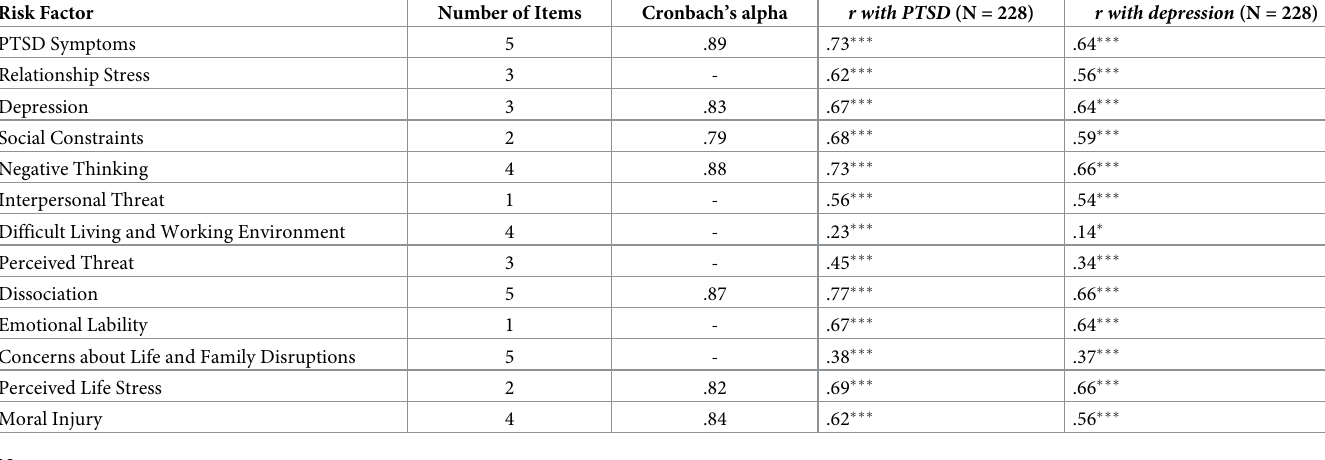
Table 4. Correlations in cross-validation study between scores for selected risk factor item sets at enrollment and PTSD and depression symptoms 6 month later.